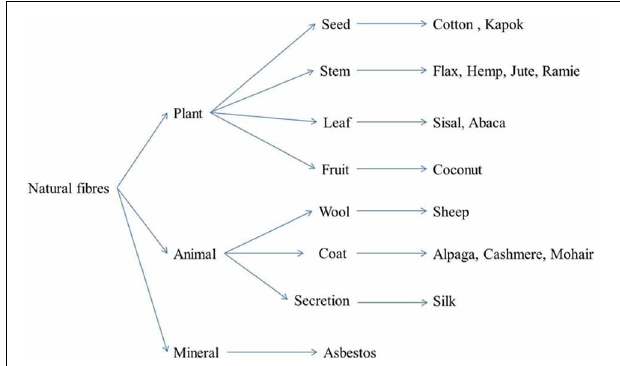
FIGURE 1 | Classification of natural fibers [inspired by Baley (2004)].